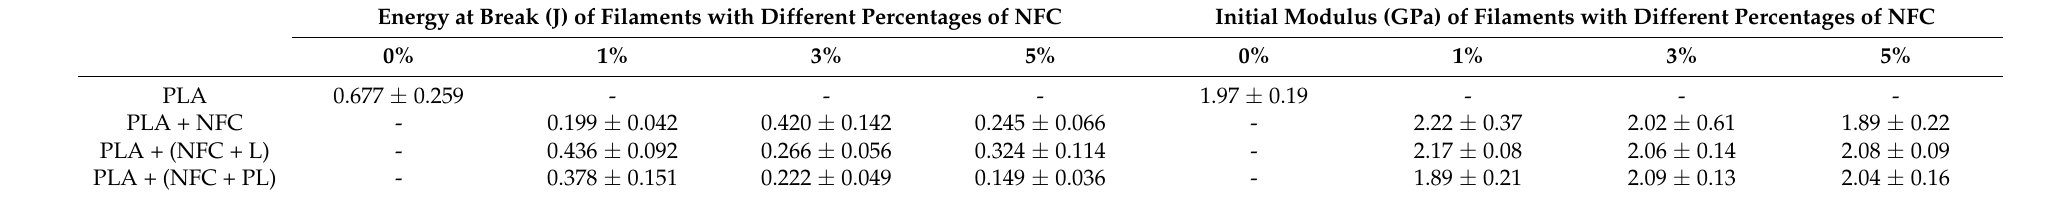
Table 4. Energy at break and initial modulus of filaments; mean value ±